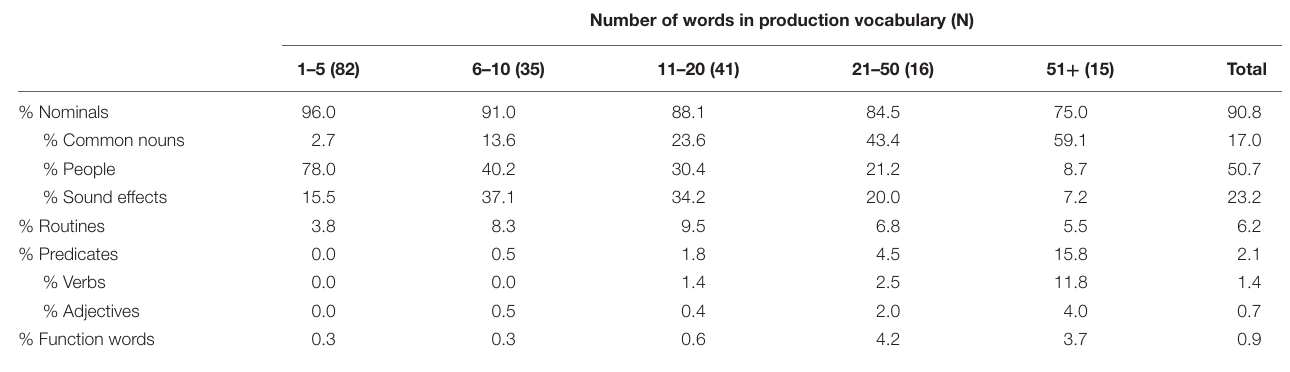
TABLE 4 | Percentages of vocabulary consisting of words in each category, across vocabulary sizes –